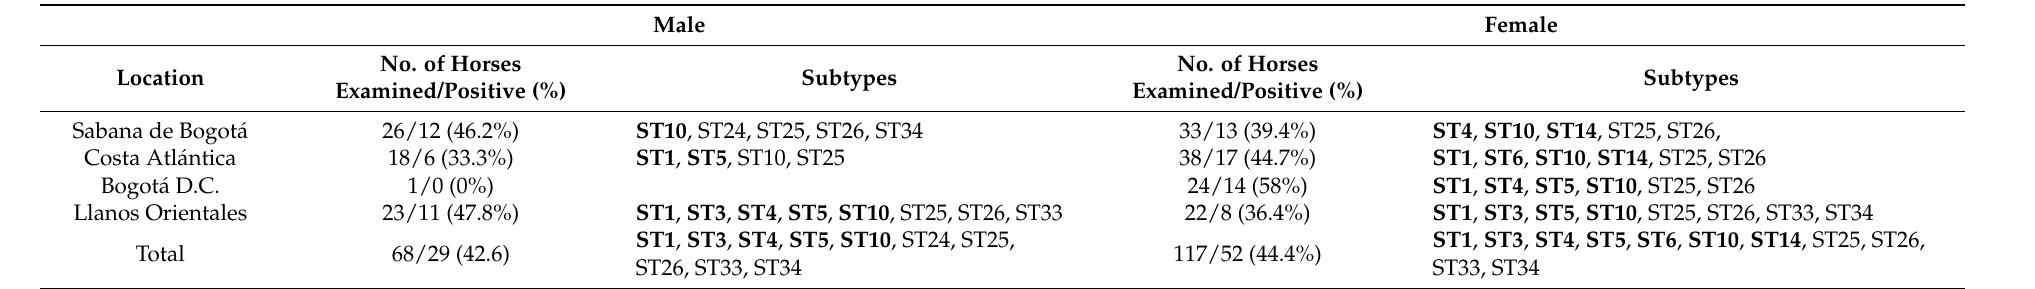
Table 4. Number of horses examined, number of horses positive, prevalence (%), and subtypes of Blastocystis by gender at each location. Subtypes in bold denote those previously identified in